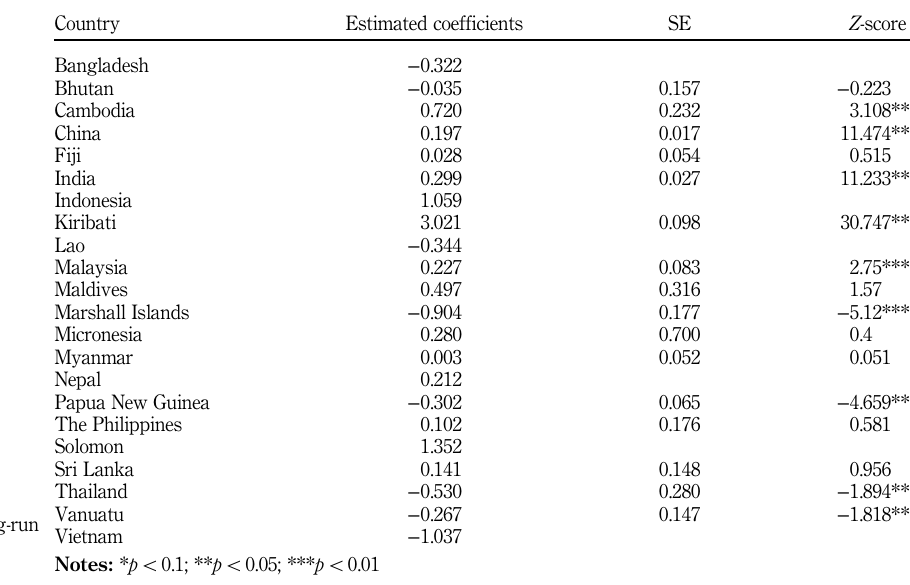
Table VI. Panel-specific long-run coefficients (1999 ‒